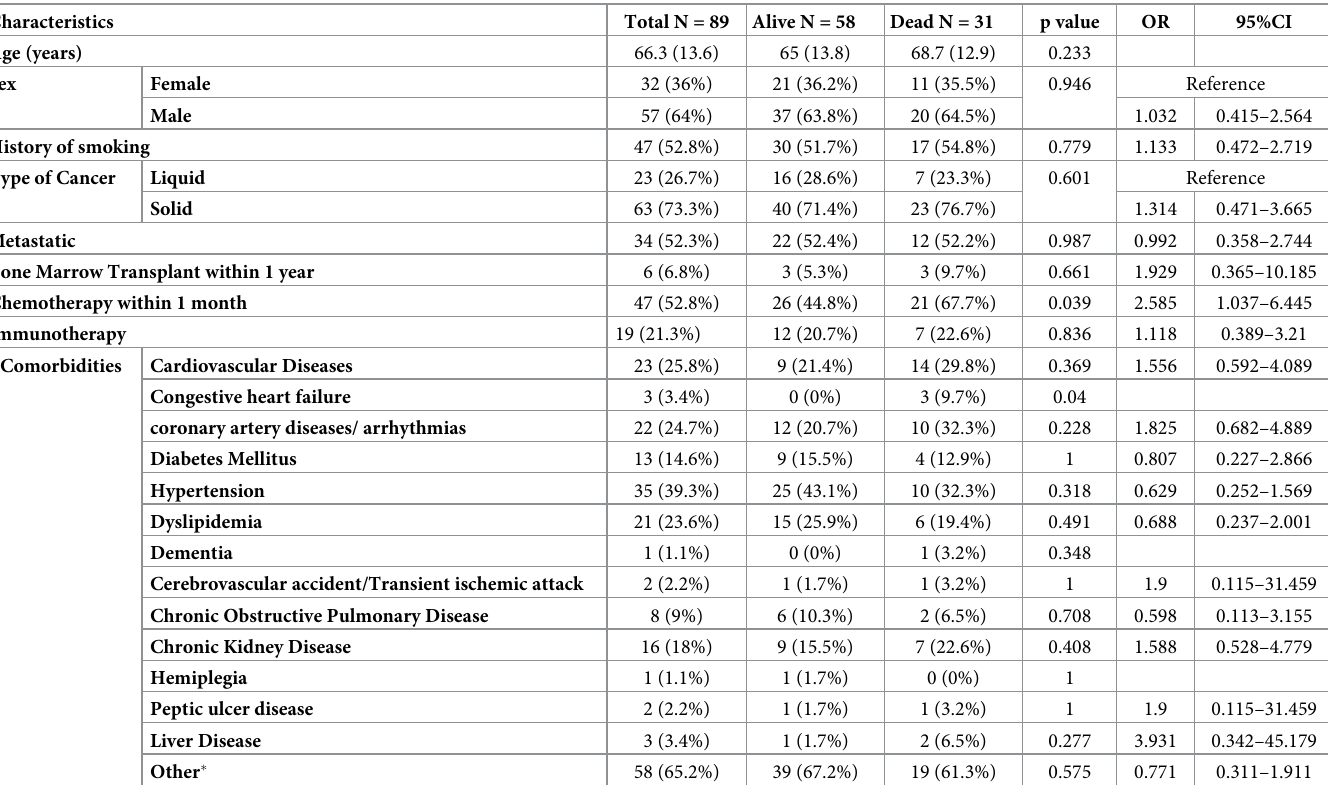
Table 1. Association of baseline characteristics of oncology COVID-19 patients with in-hospital mortality.